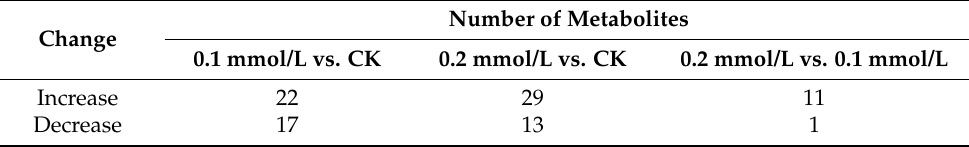
Table 2. Number of increased or decreased metabolite levels among 157 identified metabolites in the fermentation broth of Epichloë sinensis Se-treated (0.1 and 0.2 mmol/L Na 2 SeO 3 ) and untreated groups from 4 to 8 weeks of